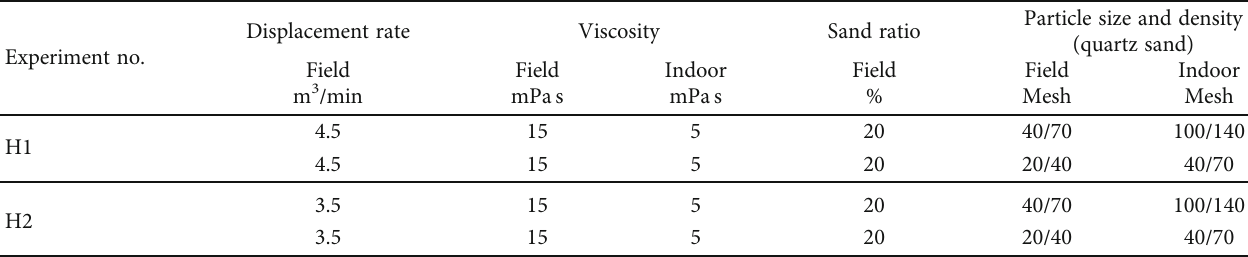
Table 6: Evaluation experiment scheme of SLG H8.